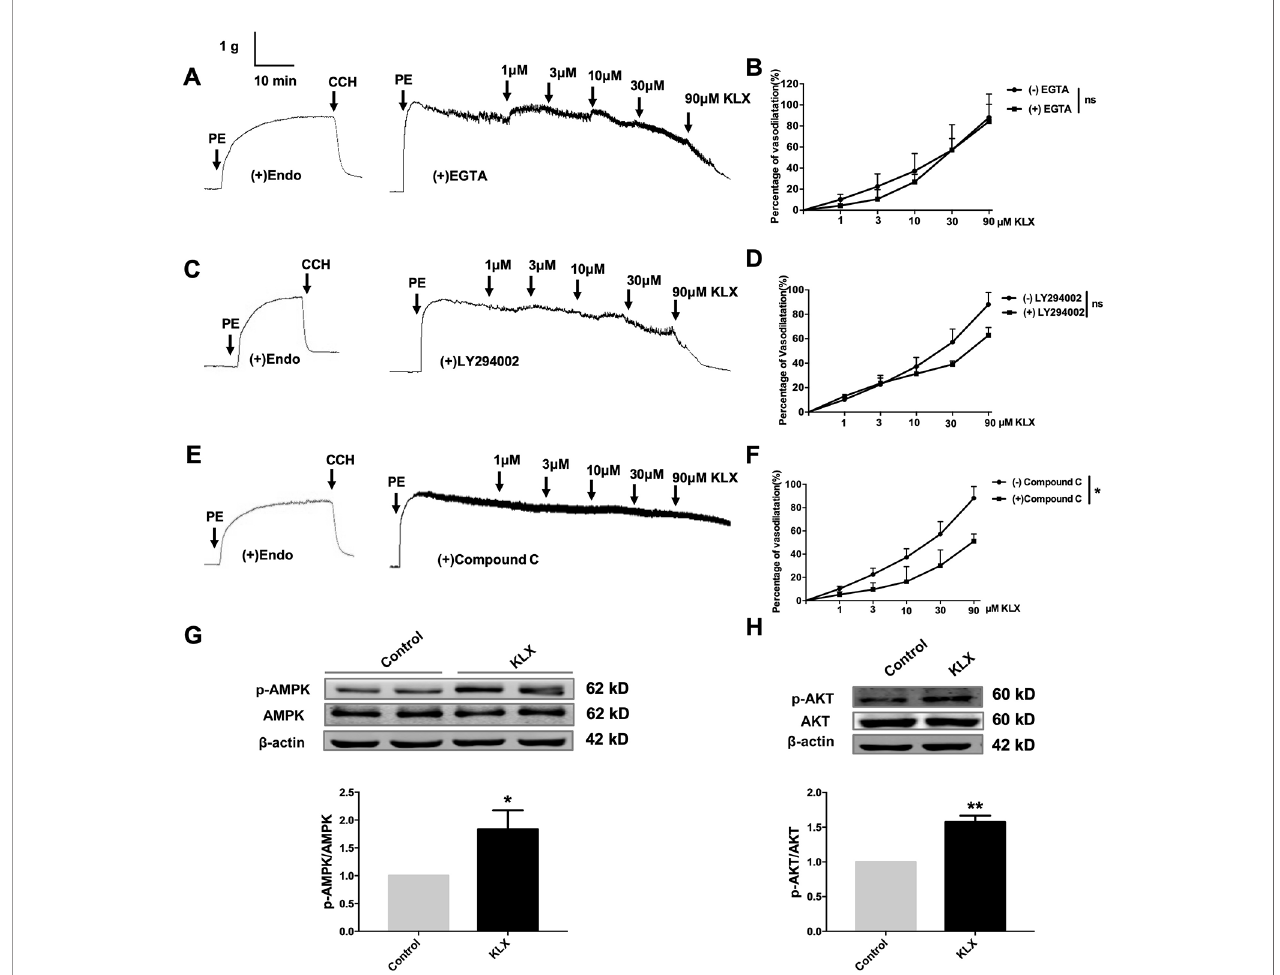
FIGURE 4 | KLX reduces vascular tension of endothelium-intact artery through activating AMPK-AKT pathway. (A) Lack of effect of EGTA (CAMKII inhibitor; 200 µM on the vasodilating effect of KLX. (B) Dose response curves of the effect of KLX on the tension of endothelium-intact vascular rings with or without pretreatment of EGTA. ns, no signi fi cance, n = 5. (C) Lack of effect of LY294002 (PI3K inhibitor; 10 µM) on the vasodilating effect of KLX. (D) Dose response curves of the effect of KLX on the tension of endothelium-intact vascular rings with or without pretreatment of LY294002. ns, no signi fi cance, n = 5. (E) Inhibitory effect of compound C (AMPK inhibitor; 10 µM) on the vasodilating effect of KLX. (F) Dose response curves of the effect of KLX on the tension of endothelium-intact vascular rings with or without pretreatment of compound C. * p < 0.05, n = 5. (G) Enhancing effect of KLX on AMPK phosphorylation in cultured HUVECs, as indicated by the increase in the phosphorylated/activated form of AMPK (p-AMPK). * p < 0.05 vs control, n = 8. (H) Enhancing effect of KLX on AKT phosphorylation in cultured HUVECs, as indicated by the increase in the phosphorylated/activated form of AKT (p-AKT). Data are presented as mean ± SEM, ** p < 0.01 vs control, n =